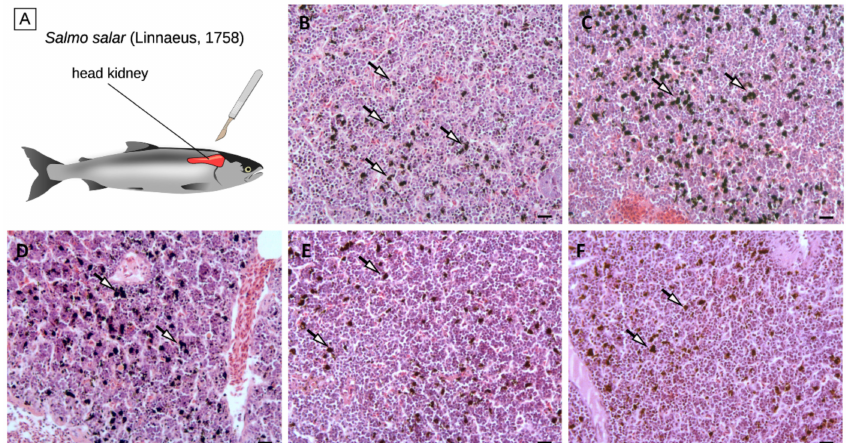
Figure 3. Schematic anatomy of Atlantic salmon, showing the location of the head kidney (panel A ). Histological section of the head kidney from salmons fed with the control (panel B ), krill meal (panel C ), soybean meal (panel D ), Bactocell ® (panel E ), and butyrate-rich diets (panel F ). Arrows indicate MMCs. Scale bar = 20 µ m. MMCs: